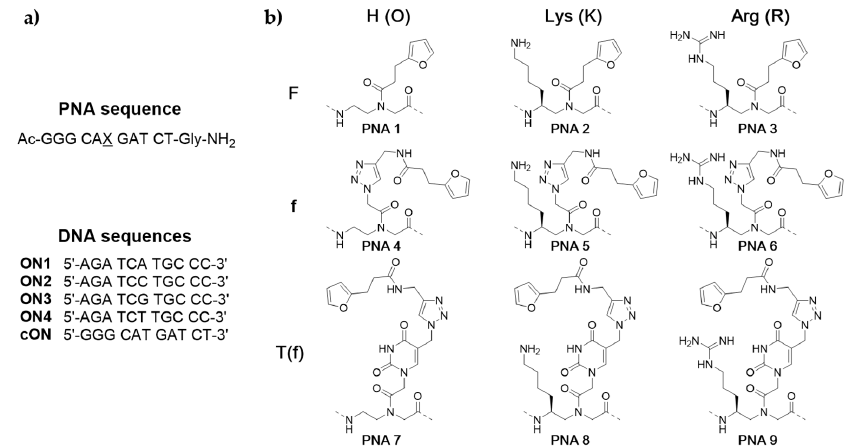
Figure 1. ( a ) Peptide nucleic acid (PNA) and DNA sequences used in this study; ( b ) Structure of the X monomers employed in this study with varying furan side- chain structure ( F , f , T ( f )) and varying backbone modification none ( O ), Lys side chain ( K ) or Arg side chain ( R ).